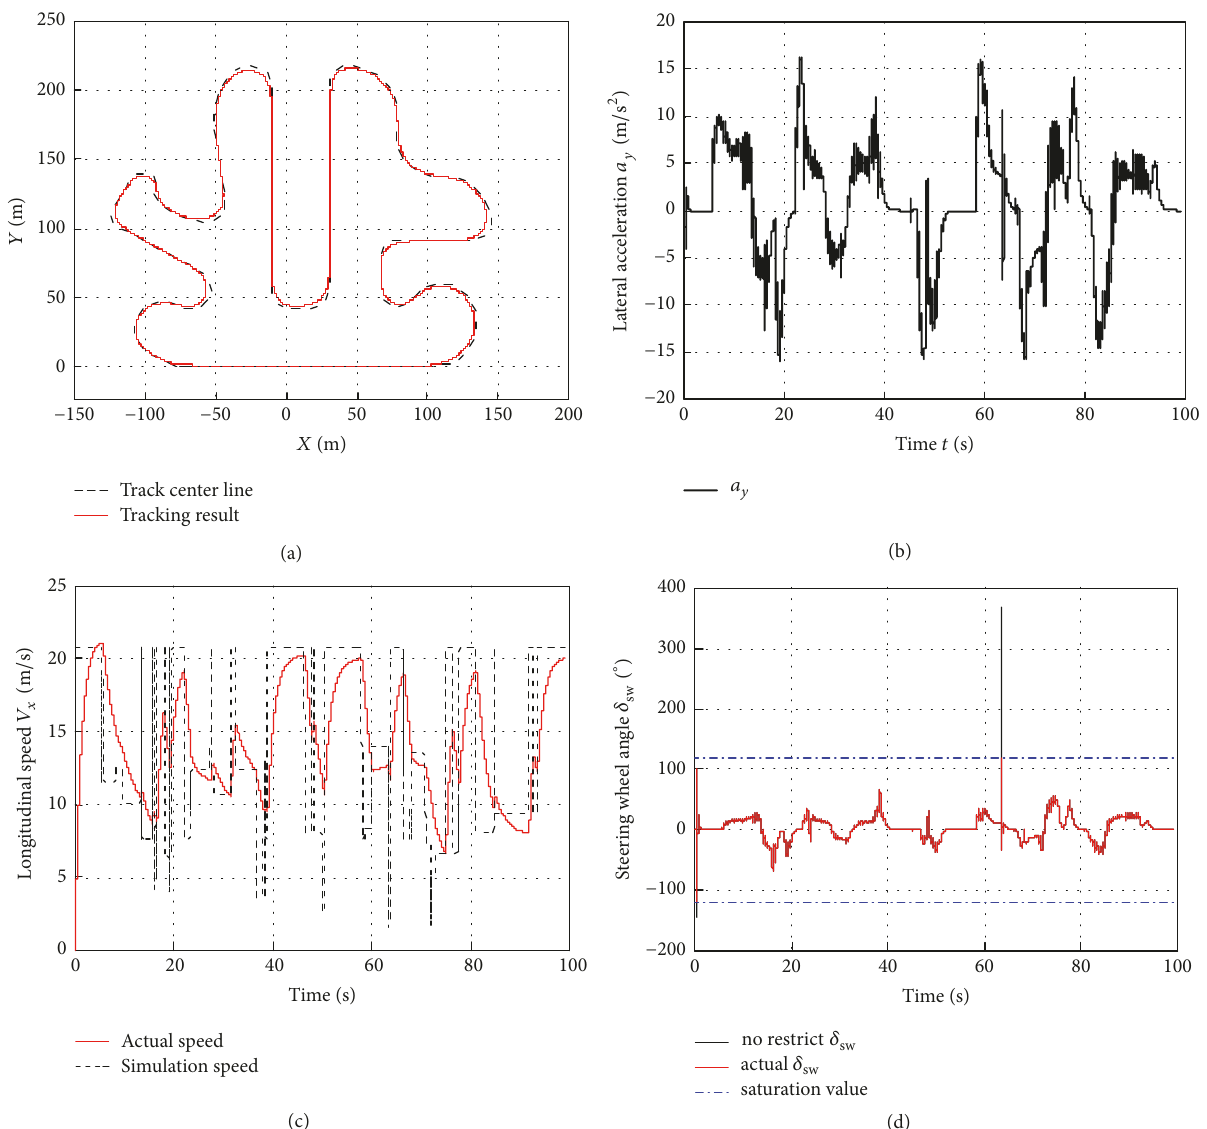
Figure 18: Simulation results. (a) Tracking. (b) Lateral acceleration. (c) Longitudinal speed. (d) Steering wheel